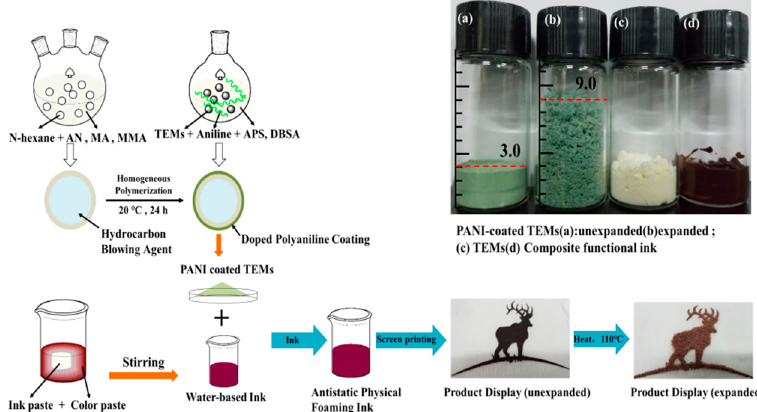
Figure 1. Synthesis of polyaniline-coated TEMs and ink preparation process.